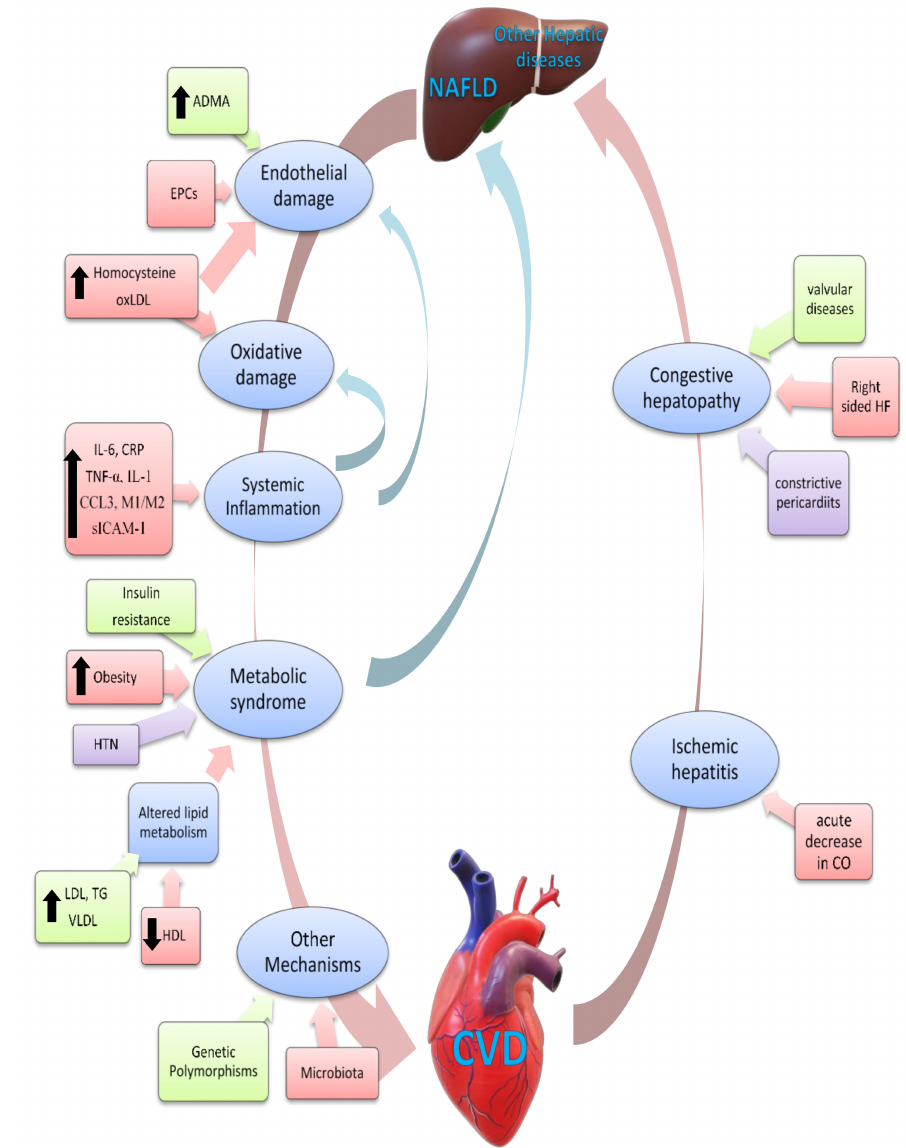
Figure 2. Summary of suggested pathophysiological mechanisms underlying the cardio hepatic interactions in NAFLD, ischemic hepatitis and congestive hepatopathy with cardiovascular diseases. ADMA, asymmetric dimethyl arginine; CCL3, chemokine ligand 3; CO, cardiac output; CRP, C- reactive protein; EPCs, endothelial progenitor cells; HDL, high-density lipoproteins; HF, heart failure; HTN, hypertension; IL-1, interleukin 1; IL-6, interleukin 6; LDL, low-density lipoprotein; M1/M2, macrophage phenotype 1/2 ratio; NAFLD: non-alcoholic fatty liver disease; OxLDL oxidized low- density lipoprotein; sICAM, soluble intracellular adhesion molecule; TG, Triglycerides; TNF- α , tumor necrosis factor α ; VLDL, very low-density